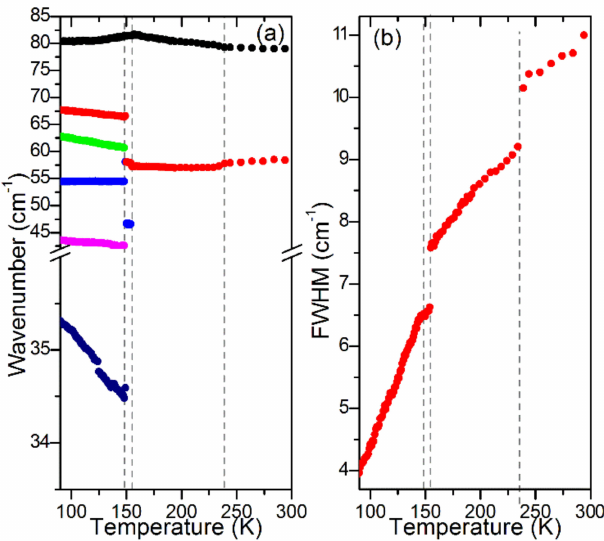
Figure 4. Plots of Raman ( a ) wavenumbers and ( b ) FWHM for lattice modes of a MAPbBr 3 single crystal. The same color in ( a , b ) denotes data for the same Raman